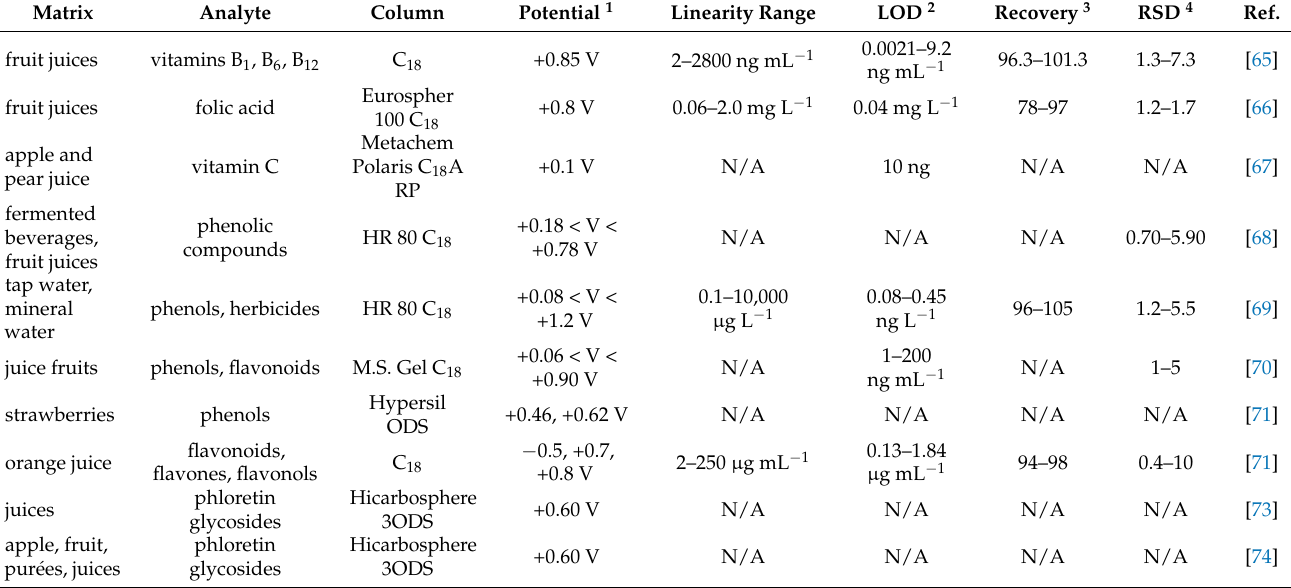
Table 4. HPLC-ED analysis performance in the analysis of different compounds in fruit and juice fruit matrices. The term “N/A” means the information is absent in the